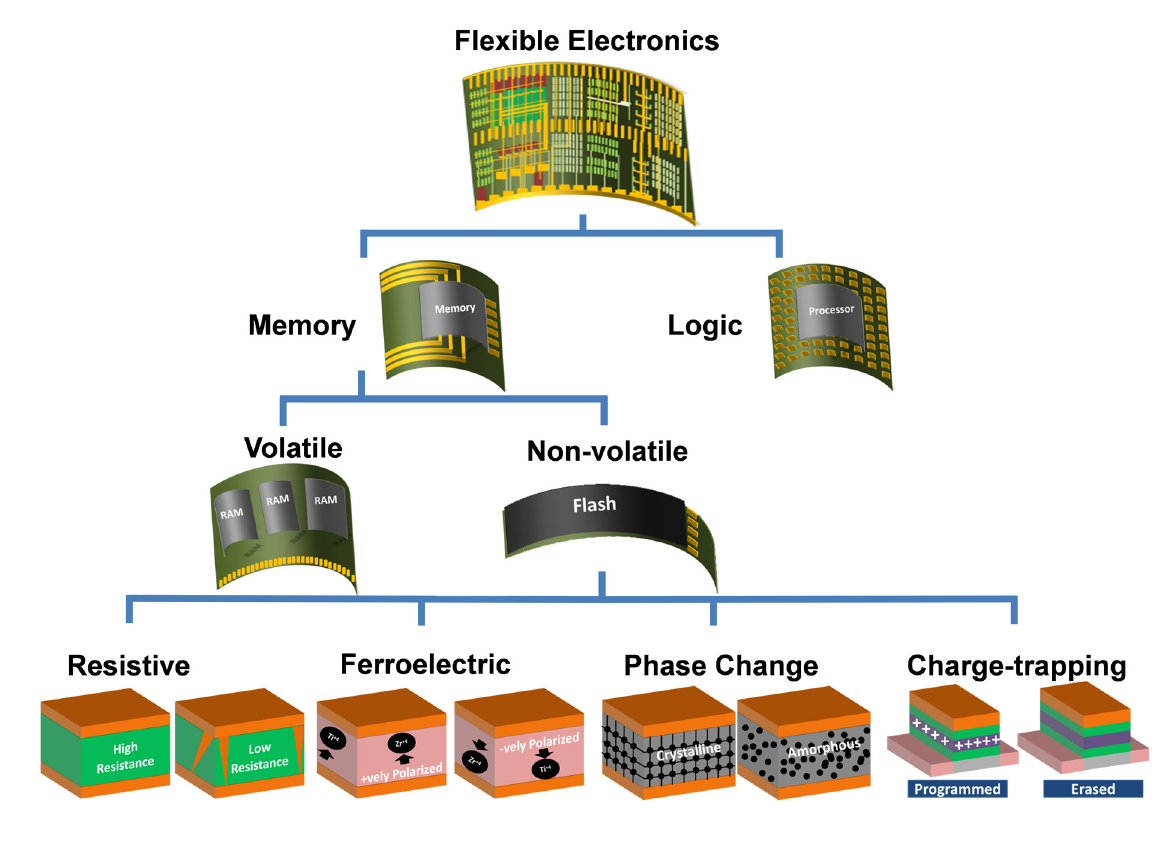
Figure 1. Chart highlighting the focus of the